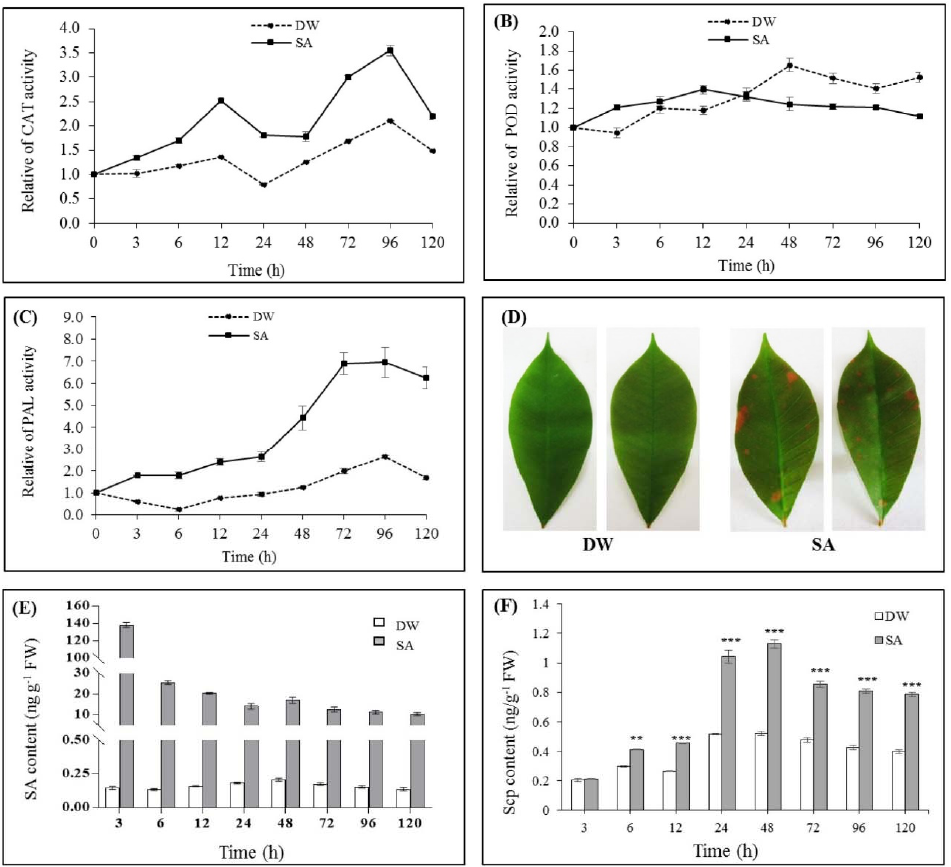
Figure 4. The effect of SA on ( A ) CAT; ( B ) POD; ( C ) PAL activities; ( D ) lignin; ( E ) endogenous SA; and ( F ) Scp contents in rubber tree. The leaves of rubber tree seedlings were sprayed with either distilled water (DW) as control or 5 mM SA and harvested at different points of time (3, 6, 12, 24, 48, 72, 96 and 120 h) for enzyme activity measurements by spectrophotometry and endogenous SA and Scp detections by HPLC. All data represent mean ± SE of three biological replicates of 10 seedlings. Asterisks indicate statistically significant differences in the level of Scp content in SA treatment compared to its content in the control at the same time point (** for p ≤ 0.005, *** for p ≤ 0.001), according to paired-samples t -test. Lignin deposition was visualized by phloroglucinol-HCl staining of the rubber tree leaves treated with 5 mM SA at 48 h.